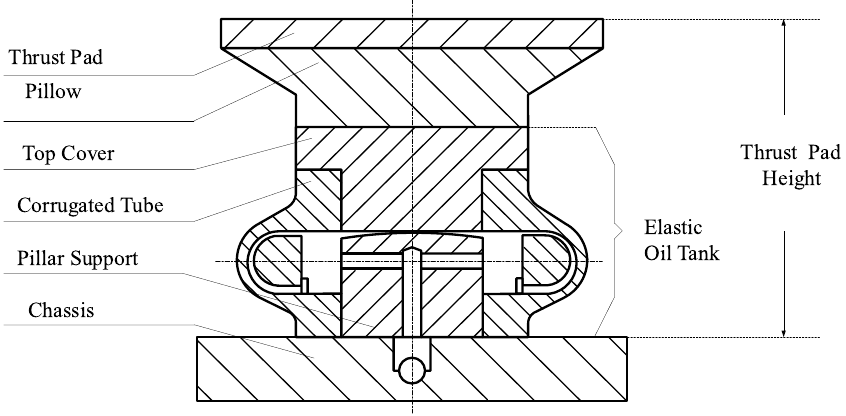
Fig. 2. Schematic diagram of support components of thrust